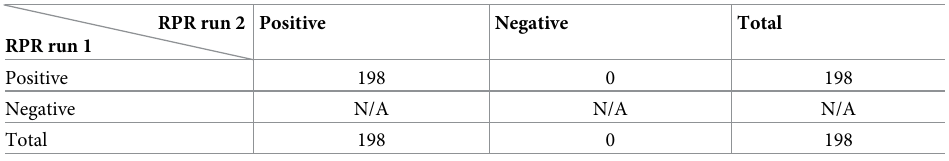
Table 5. Comparison between RPR run 1 and